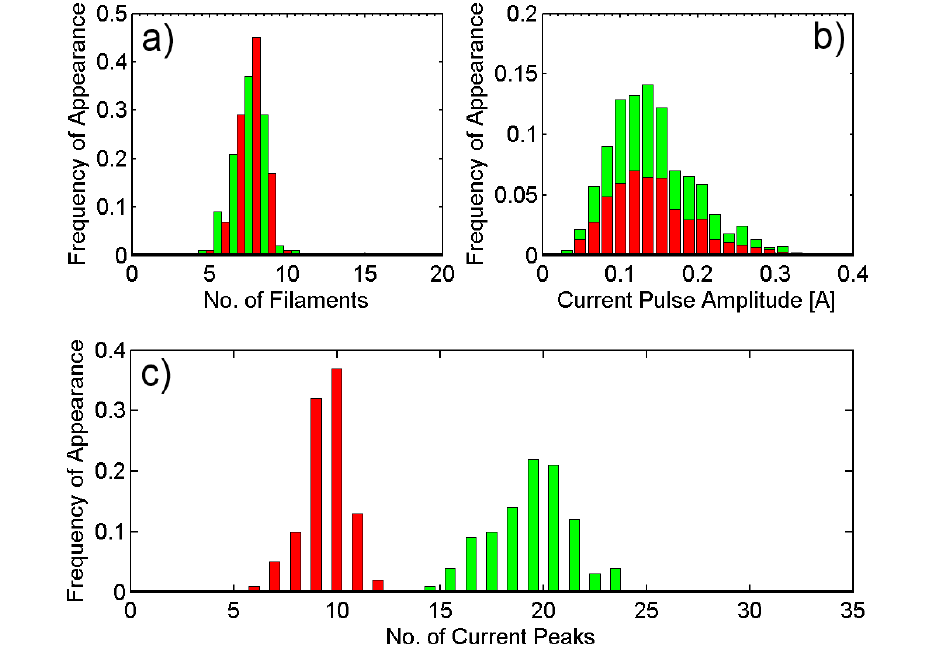
Figure 8 : Histograms of: a) number of filaments, b) distribution of microdischarges current and c) number of microdischarges. Red bars correspond to positive half-period of discharge; green bars correspond to whole period of the discharge. Discharge conditions were as follows: DCSBD generated using sine-wave HV of the amplitude of 16 kV, electrode gap width set to 2.0